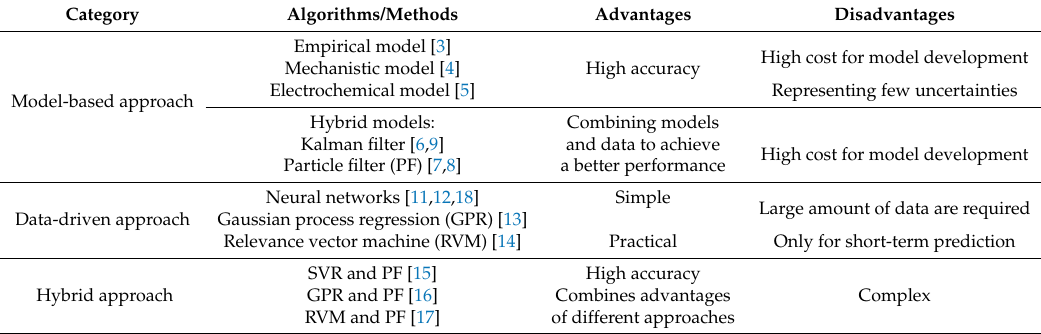
Table 1. Summary of battery state-of-health (SOH) prediction approaches. SVR: Support vector